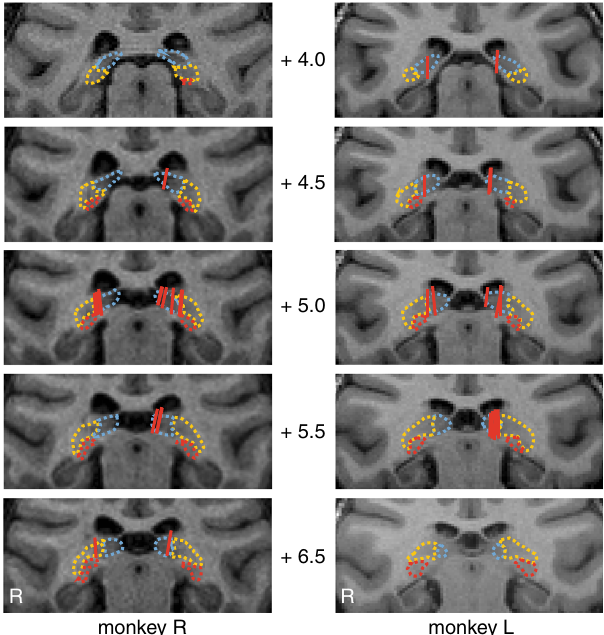
Fig. 1 Penetrations targeting the atlas-de fi ned mediodorsal pulvinar (mdPul). We previously published representative penetrations for FEF and LIP 4 . Here, a red line depicts each penetration. The numbers positioned between images from each of the animals represent anterior – posterior distances from the interaural line (mm). Atlas-de fi ned pulvinar subdivisions: dashed blue = medial pulvinar; dashed yellow = lateral pulvinar; dashed red = inferior pulvinar. The white R = right